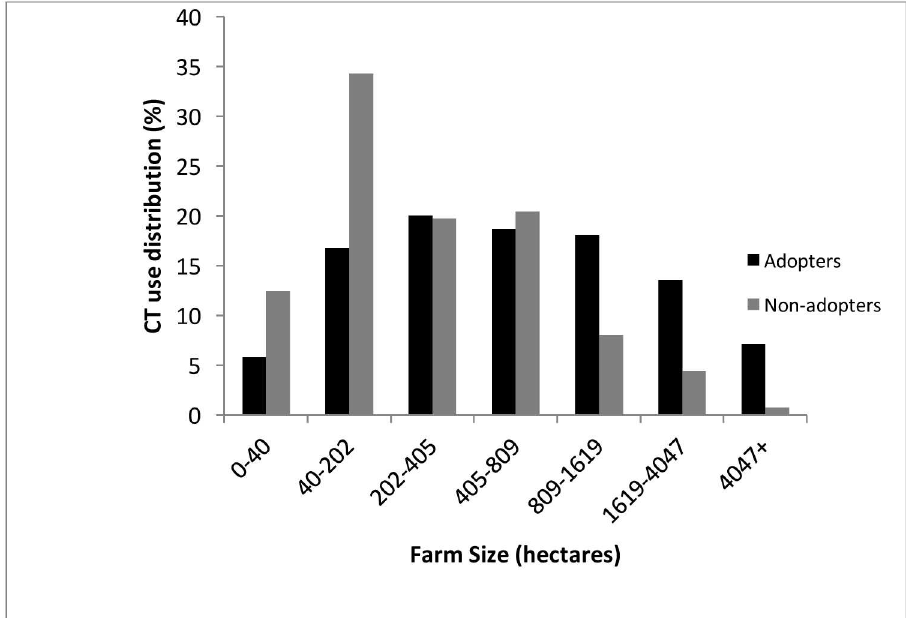
Fig 1. Farm Size of CT Adopters and